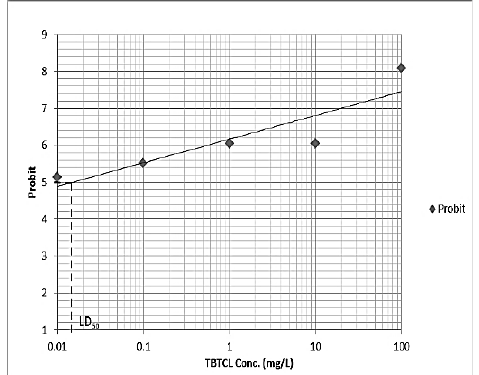
Figure 2: Acute toxicity of TBTCl on shrimps after 48 h exposure